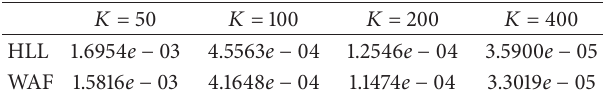
Table 2: RMS errors when 𝑁 = 1 for subcritical flow over a bump.